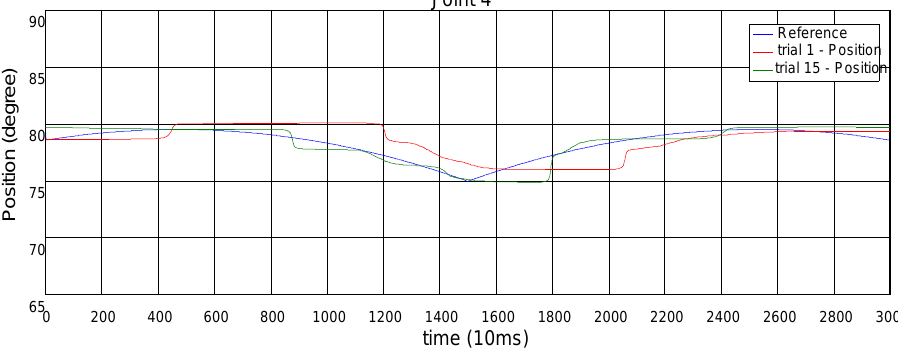
Figure 26. Trajectory 1 — 4th-axis (load-on) ILC trial 1 and trial 15 tracking and error diagrams. Table 9. Trajectory 1 (load-on) ILC controller parameters table. Rehabilitation Trajectory 1 +